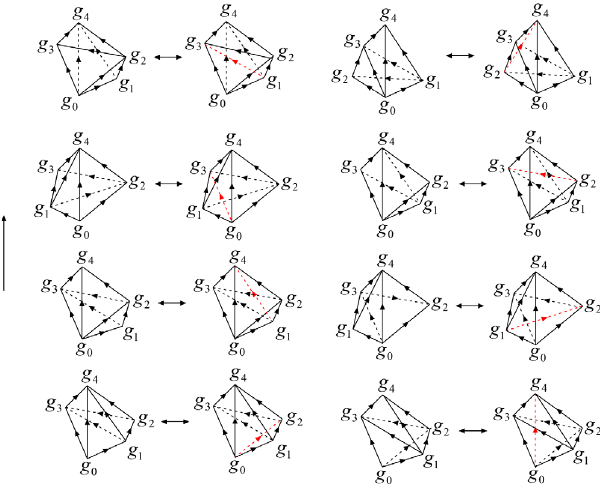
FIG. 17. All possible 3D (2-3) moves that admit a branching structure.